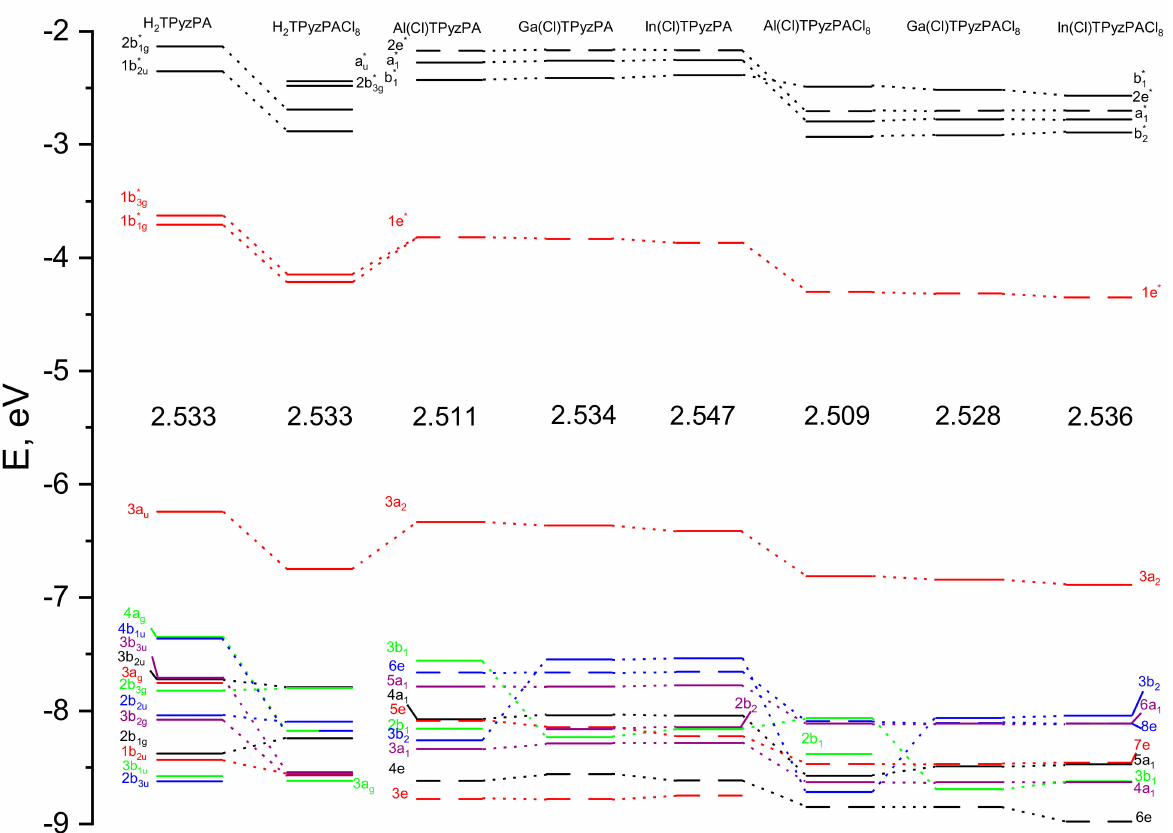
Figure 4. Molecular orbitals (MO) level diagram for H 2 TPyzPA, H 2 TPyzPACl 8 , M(Cl)TPyzPA and M(Cl)TPyzPACl 8 complexes. The values of higher occupied molecular orbital–lowest unoccupied molecular orbital (HOMO–LUMO) gaps are given in